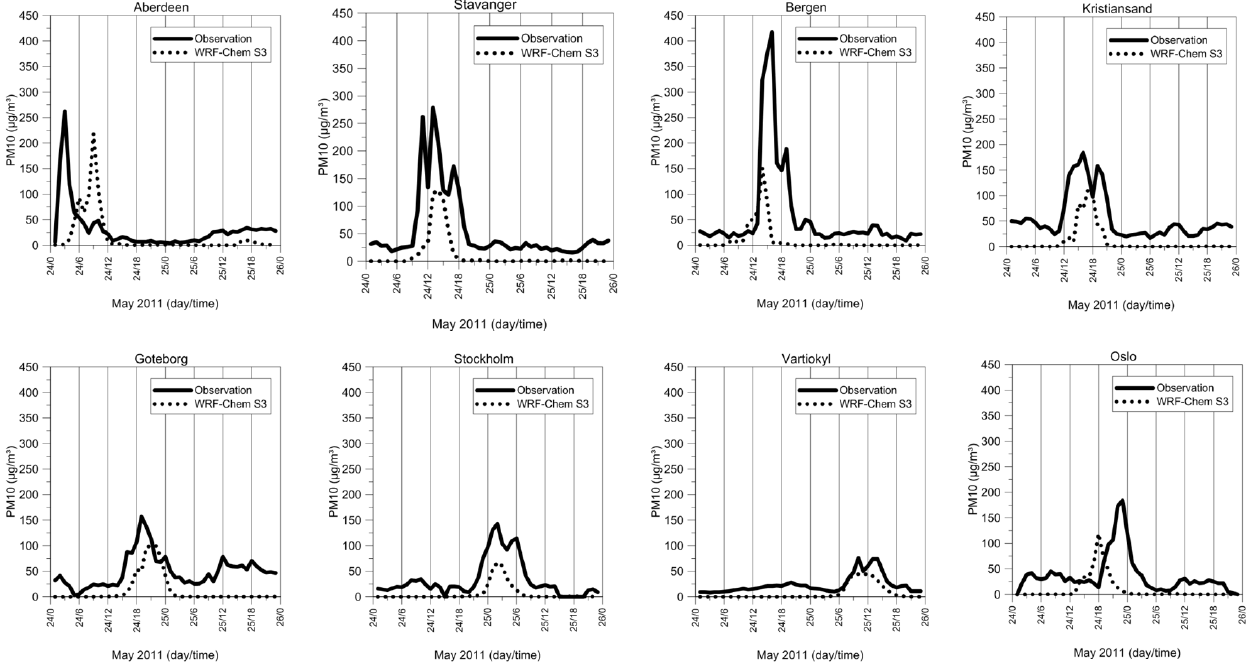
Figure 12. Time series of observed PM 10 (µg/m 3 ) ground concentrations (solid line) and WRF-Chem (S3) simulations (dotted line) for 24 and 25 May